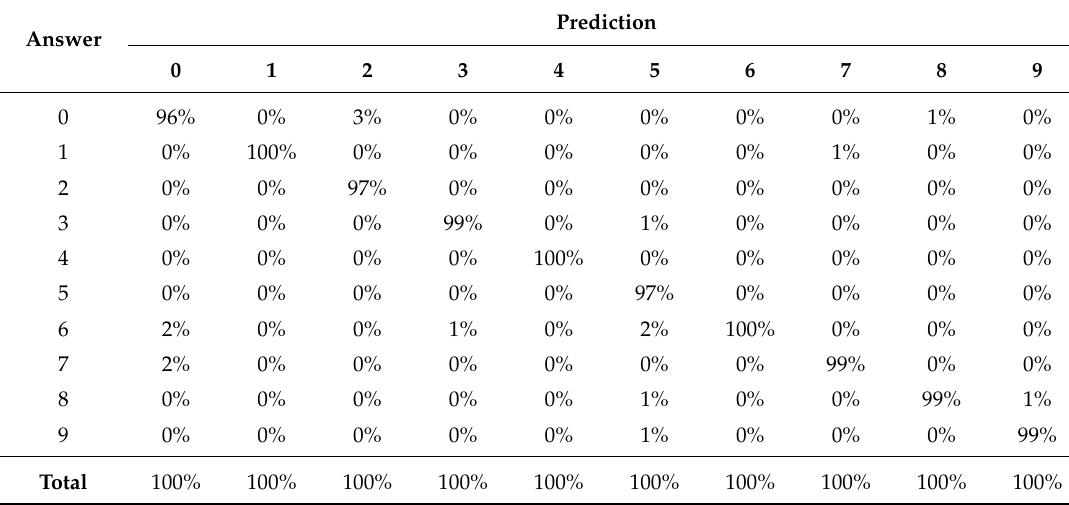
Table 2. Confusion matrix of the proposed